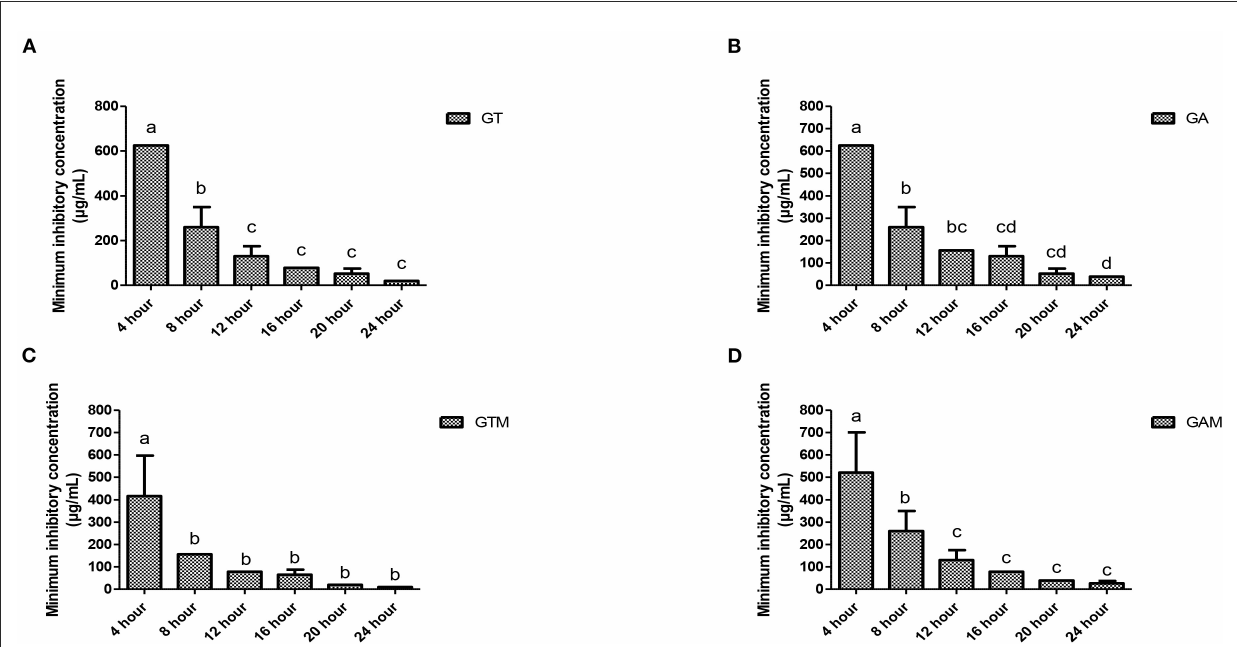
FIGURE3 (A–D) Comparison of minimum inhibitory concentrations ( µ g/mL) among different incubation times for each preparation against K. pneumoniae . (A) GT, sodium alginate-stabilized tylosin. (B) GA, sodium alginate-stabilized ampicillin. (C) GTM, sodium alginate-stabilized tylosin and MgO